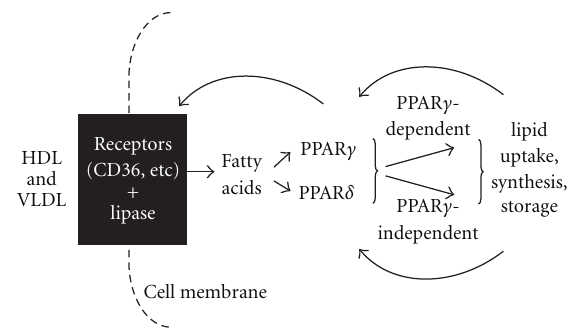
Figure 5: Feed-forward model of sebocyte di ff erentiation. We postulate that lipoproteins target lipid substrates within skin to sebocytes through interactions with specific receptors. The sub- strates in turn stimulate sebocyte di ff erentiation by acting through cell-specific PPAR γ -mediated lipogenic pathways.